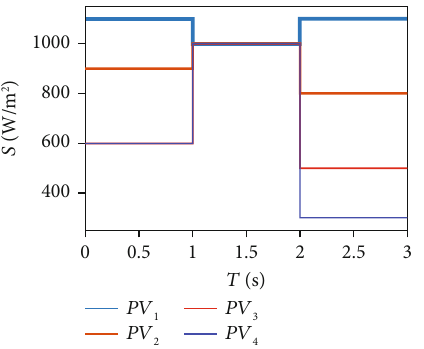
Figure 18: Solar irradiance variations of PV modules.